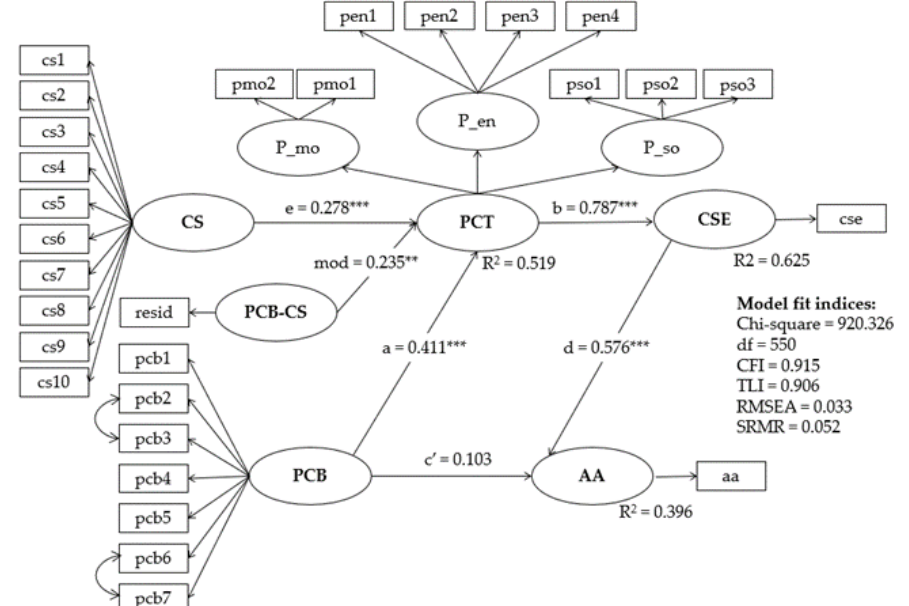
Figure 5. Standardized path coefficients of moderated mediation structural equation model (outcome variable = AA). ** refers p < 0.05 and *** refers p < 0.001. Note. PCB = Perceived crime benefit, PCT = Proactive criminal thinking, P_mo = Mollification, P_en = Entitlement, P_so = Super-optimism, CSE = Criminal self-efficacy, AA = Arrest avoidance CS = Crime strategy. PCB_CS = Interaction between PCB and CS.